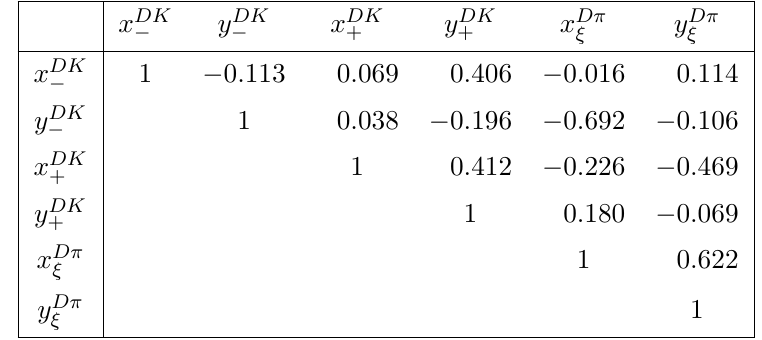
Table 5 . External inputs c i , s i systematics correlation matrix obtained for the combined Belle and Belle II data set.